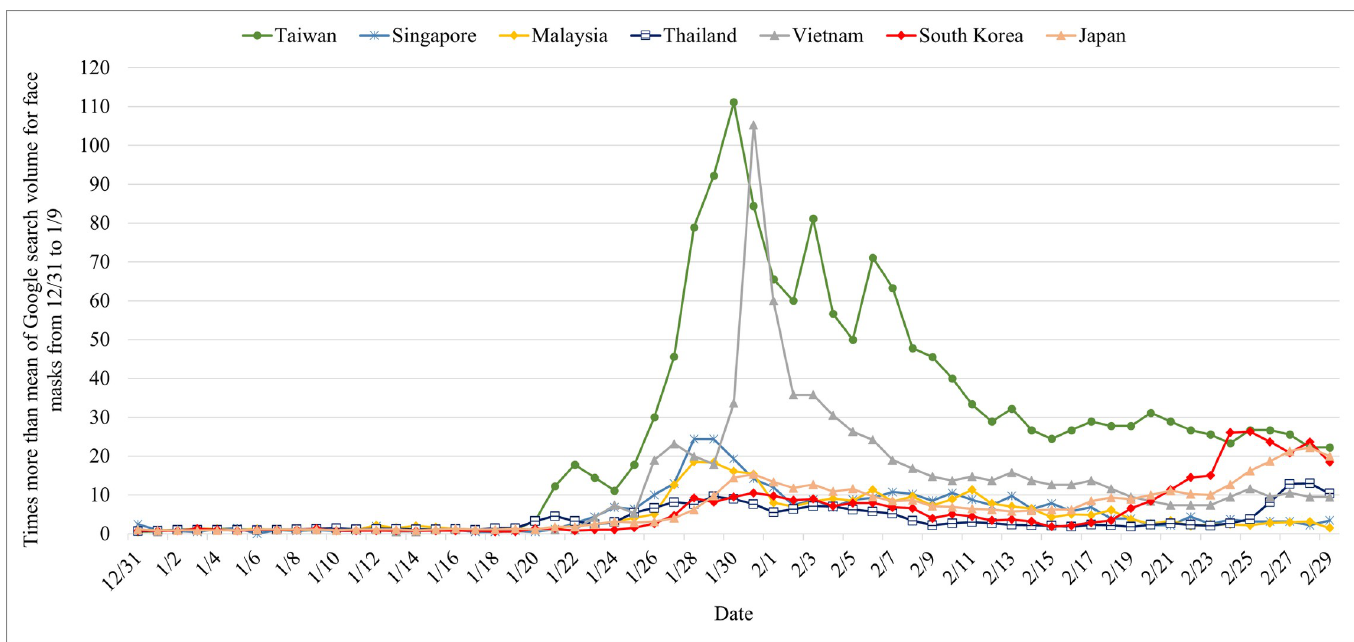
Fig 1. The trend chart for the number of news reports on COVID-19, the volume of mentions of COVID-19 and face masks on social media, and total confirmed cases worldwide and in Taiwan between December 31, 2019 and February 29, 2020.